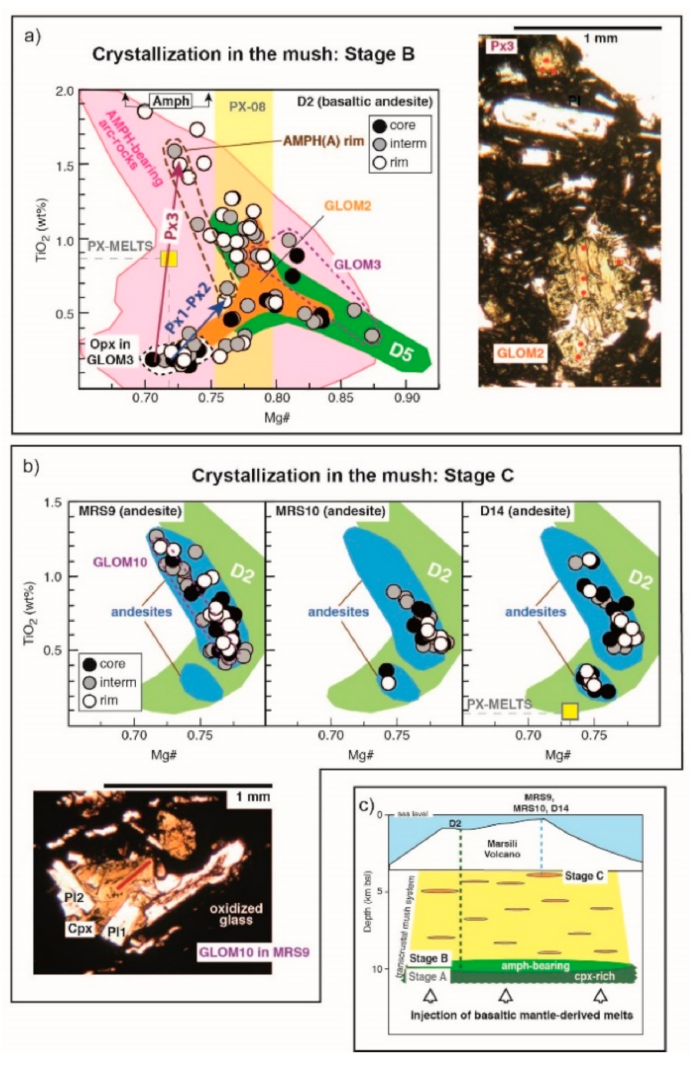
Figure 3. Clinopyroxene variability indicative of Stage B and Stage C crystallization. ( a ) TiO 2 (wt%) versus Mg# for sample D2 clinopyroxene crystals. This cargo records Stage B events, storage zone reported in ( c ). The D2 clinopyroxene trend defines a continuum with the field of D5 clinopyroxenes (Stage A, green field) before splitting into two branches at the lowest Mg# values (see GLOM2, orange field), pointing, respectively, to the compositional fields of orthopyroxene (low Ti, black dotted field) and amphibole (high Ti; Amph, black arrows) carried in the D2 lava [18]. The crystals are tagged as in Figure 2; further photomicrographs are reported in Supporting Materials (Figure S2). A similar Mg#-TiO 2 relationship is shown by clinopyroxene cargoes from basic arc lavas (pink-coloured field), formed during cryptic amphibole crystallization in the crust [32,40,41]. ( b ) TiO 2 (wt%) versus Mg# for the few pyroxene crystals carried in the MRS9, MRS10, D14 andesite lavas (light blue fields). These cargoes consist of orthopyroxene (Opx) and clinopyroxene (Cpx) crystals recording Stage C crystallization events, storage zone reported in ( c ). Note the large TiO 2 range at the low Mg# values of the clinopyroxene crystals, with some individual crystals (e.g., GLOM10 in MRS9 lava) covering this range, and the close match of andesite clinopyroxene compositions with the most differentiated end of the D2 clinopyroxenes (Stage B). Analytical error, yellow box and vertical band are displayed as in Figure 2. Other mineral abbreviations: Opx = orthopyroxene; Amph = amphibole. ( c ) Cross section of the multitiered magma plumbing system beneath Marsili Volcano, as in Figure 1c. Boxes “Stage B” and “Stage C” mark the location of the crystallization events recorded by the clinopyroxene cargoes of the D2 basaltic andesite and the andesite lavas,